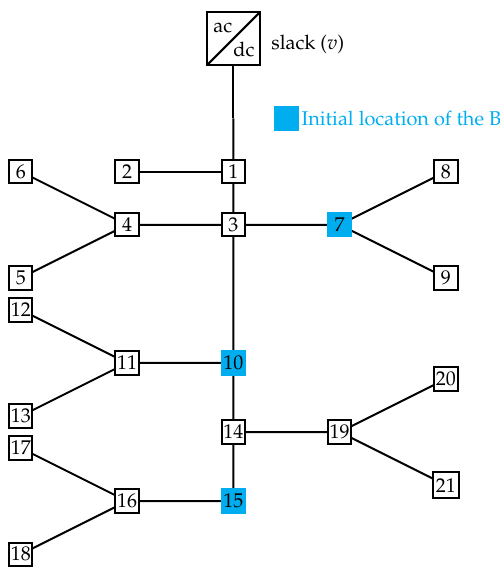
Figure 3. Electrical topology for the 21-bus system.